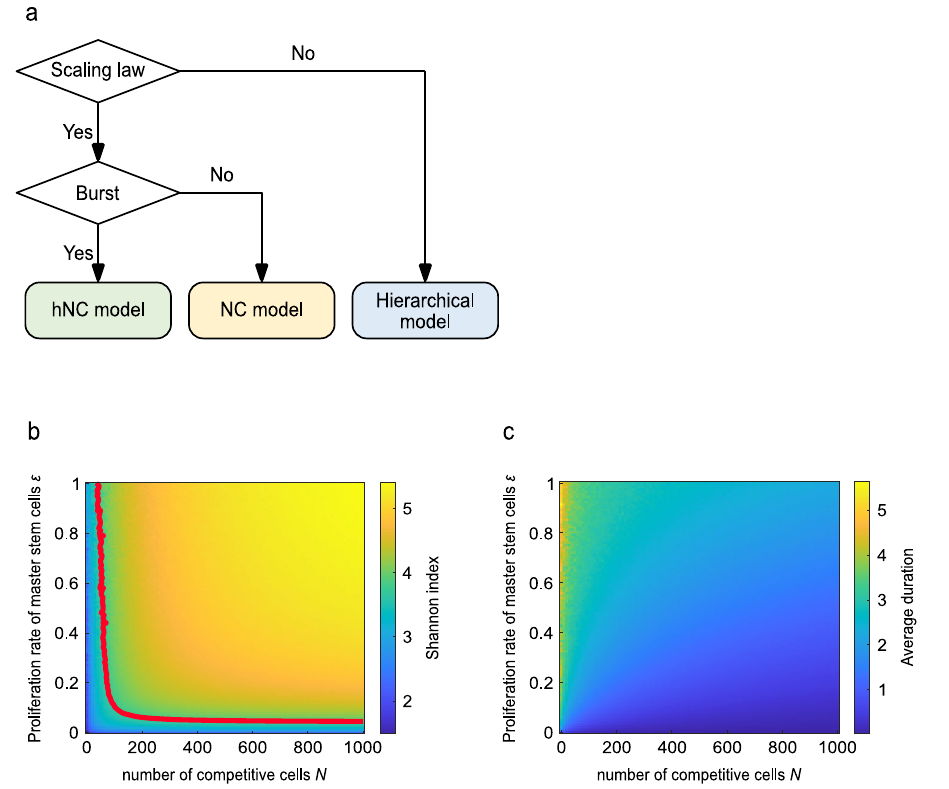
Fig. 6 Criterion to experimentally distinguish the hierarchical, NC, and hNC models. a Flow chart of criterion to distinguish the hierarchical, NC, and hNC models. Scaling law of clone size distribution can be used as an indicator to distinguish the hierarchical model and other two models. Clonal bursts can be used as an indicator to distinguish the NC model and hNC model. b , c Two types of experimentally-measurable variables depending on the proliferation rate of master stem cells, ε . The Shannon index H representing clonal diversity ( b ) and average duration of all bursts ( c ) are shown. Given the total number of competitive stem cells N , ε can be estimated using Shannon index and/or the average duration of all bursts, both of which can be measured through lineage tracing experiments of multiple clones. Red line in ( b ) indicates the contour at H = 3.64, which was calculated from the experimental data of primate hematopoiesis in Fig. 5a 20